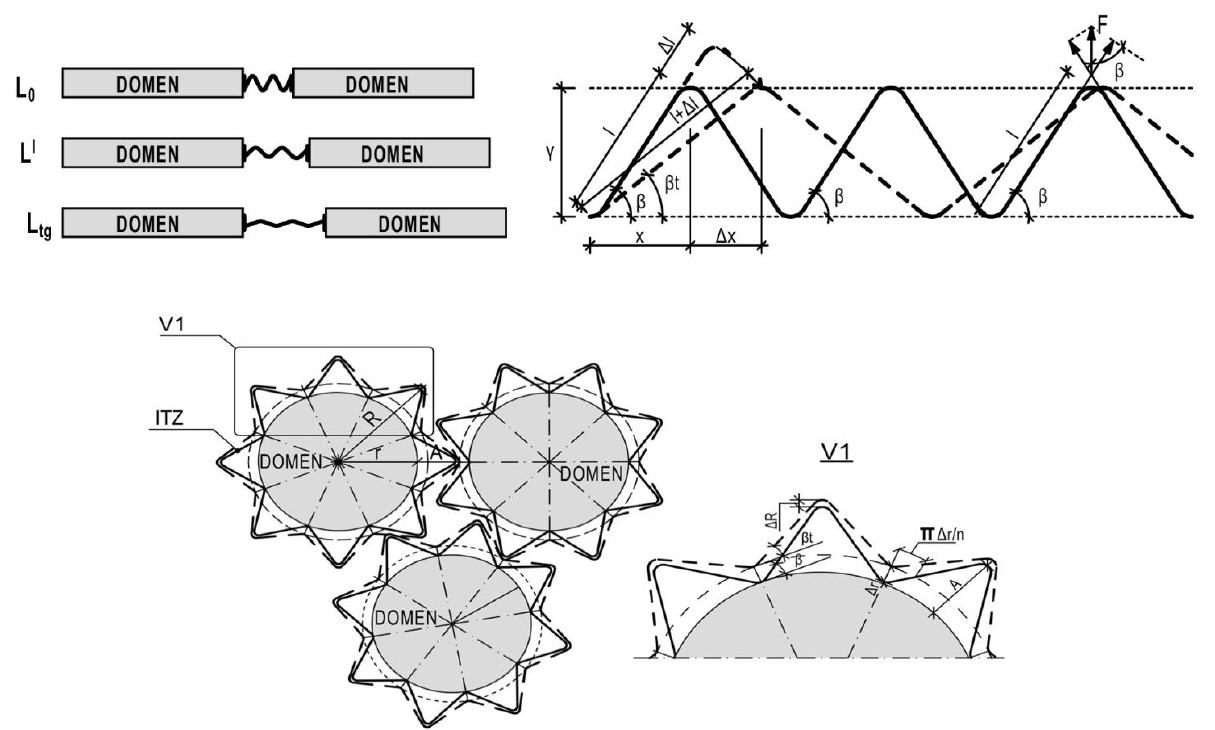
Figure 7. Two-phase relaxation model of polymer expanding under heating.